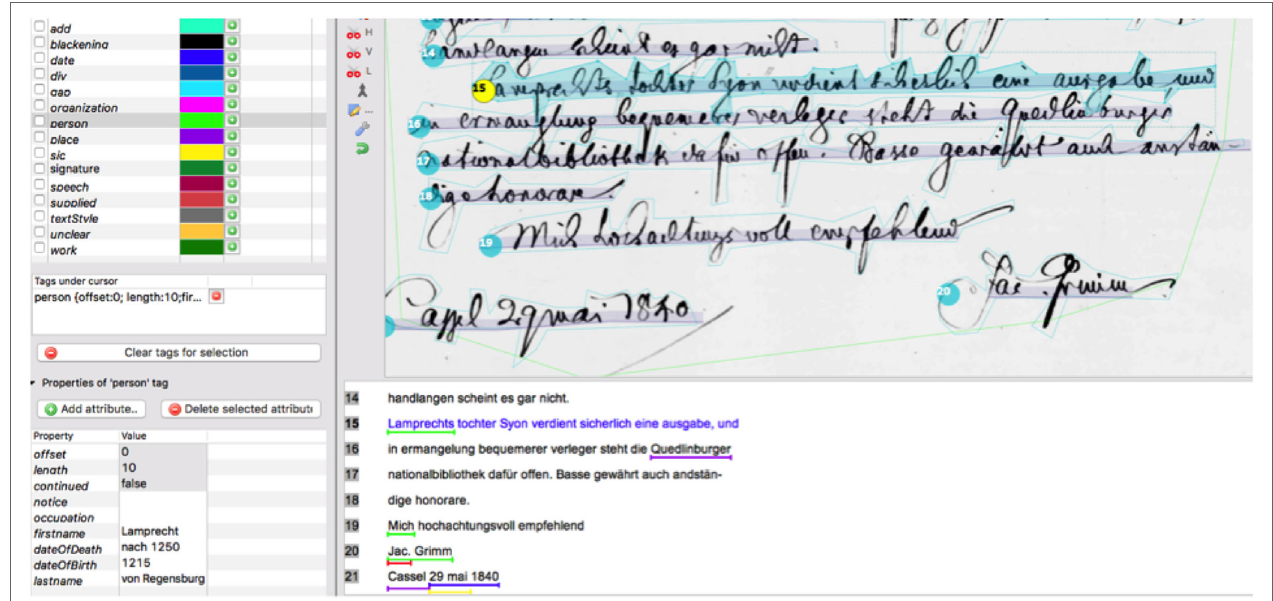
FigUre 3 | The Transkribus transcription environment. The screen is split into three areas: the left sidebar contains metadata and annotation functionality; the top area displays the original document (Br 2238, Jacob Grimm); and the bottom area contains the annotated transcription [Image reproduced with permission of the Hessisches Staatsarchiv